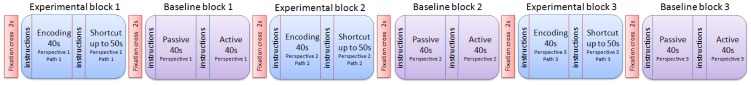
Schematic representation of events during an fMRI scanning session.